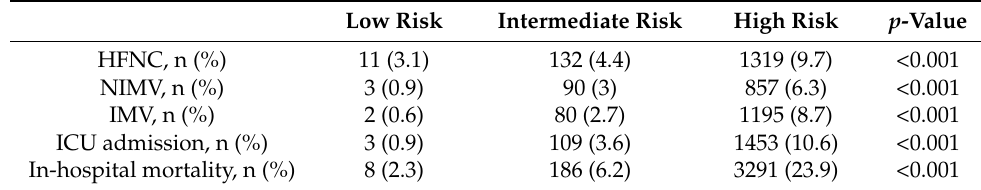
Table 5. Outcomes for the three categories.